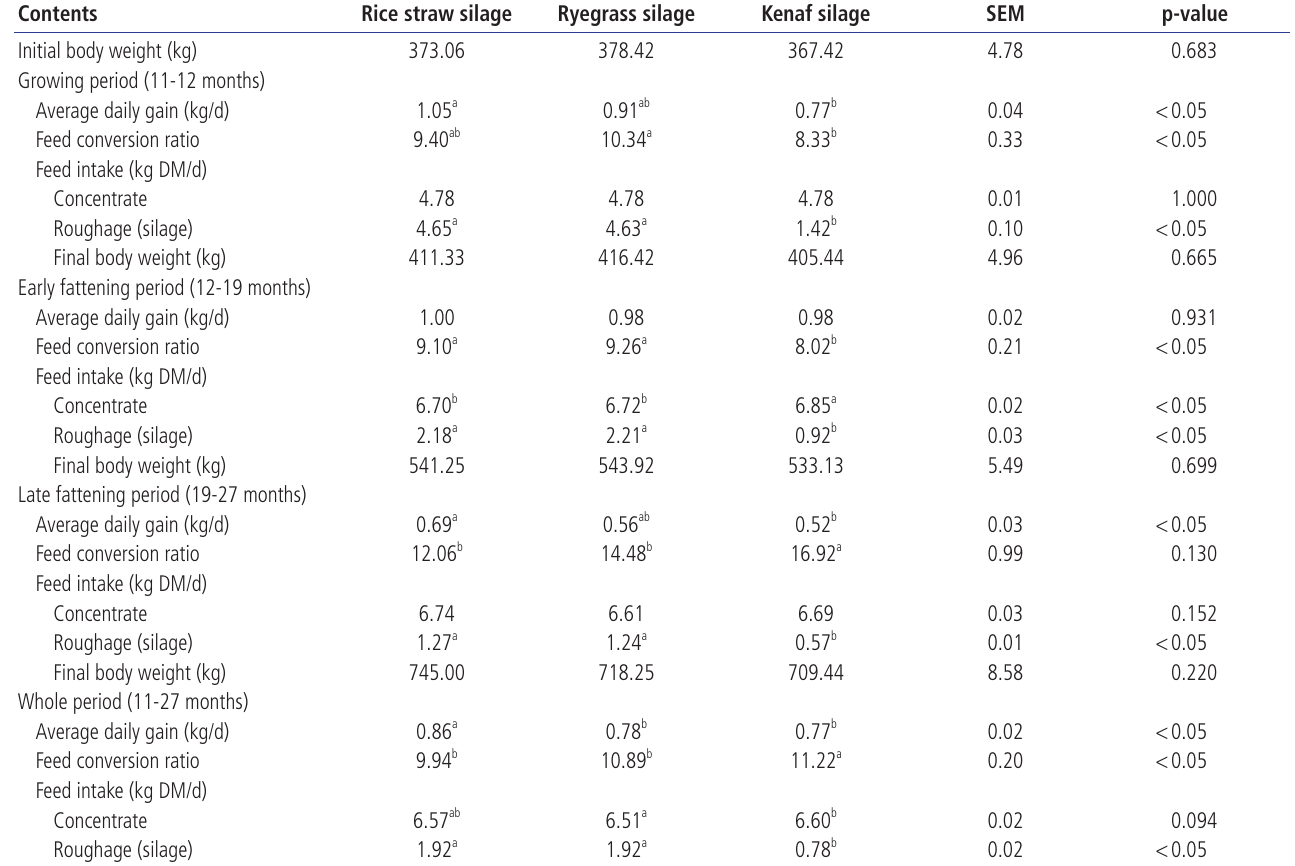
Table 3. Effect of kenaf silage feeding on growth performance of Hanwoo